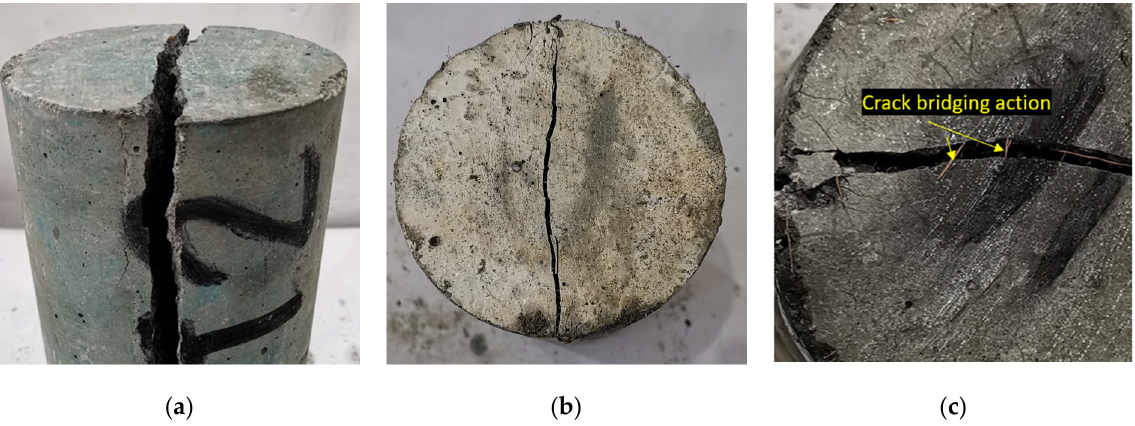
Figure 12. Overview of splitting tensile failure: ( a ) plain HSC; ( b ) HSC with 1.5% coir; ( c ) crack- bridging action of coir.